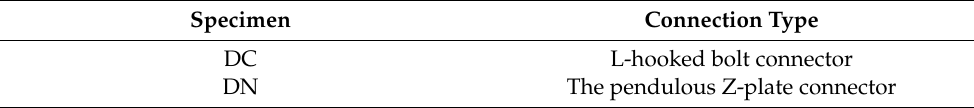
Table 1. Specimen’s main connection method.